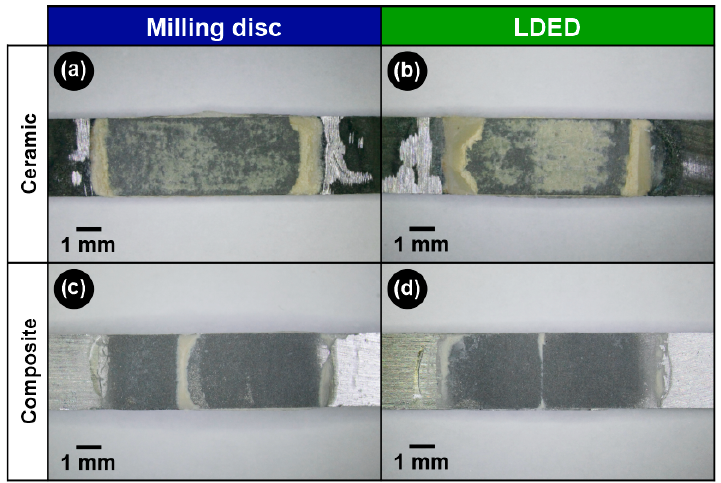
Figure 11. Optical microscopy images of surfaces after debonding for both milling disc ( a , c ) and LDED ( b , d ) materials using ceramic-veneering ( a , b ) and composite-veneering ( c , d )